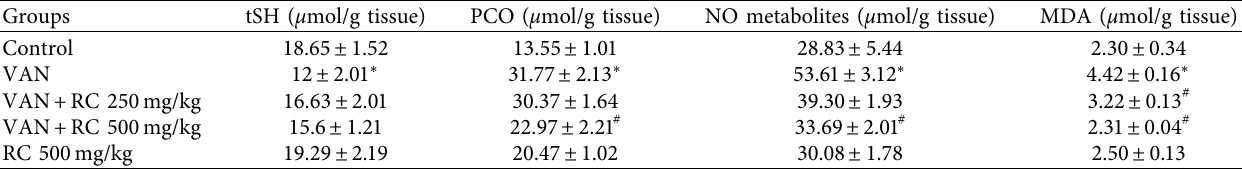
Table 1: Effect of RC extract on oxidative stress markers in VAN-treated rat kidney. Groups